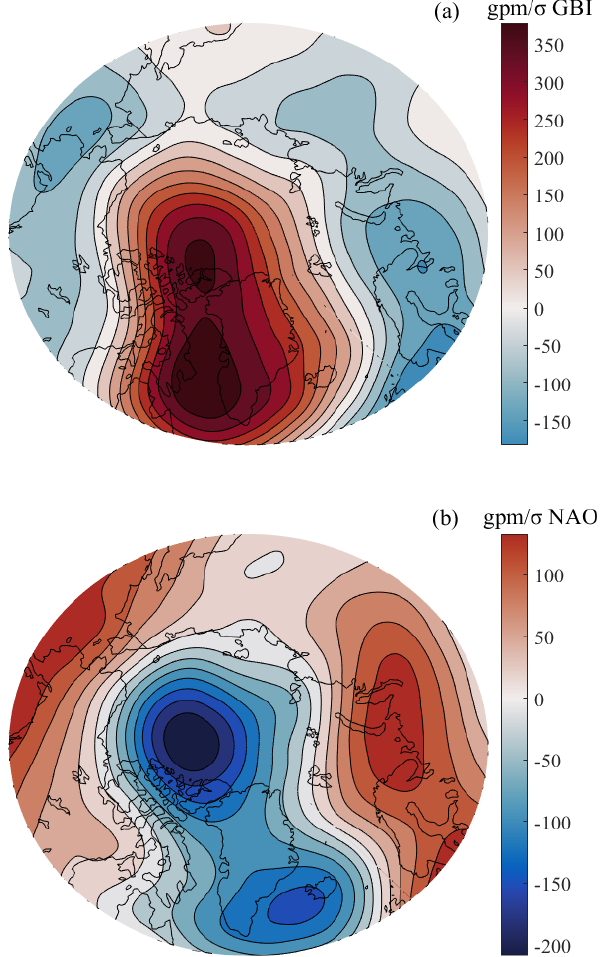
Figure 13. Regression fields slope of 2000–2018 JJA 500hPa geopotential height from ERA5 regressed with GBI (a) and NAO (b) index. Slope maps are scaled to show the 500hPa geopo- tential height change from ERA5 in geopotential meters (in gpm) for a 1 standard deviation change in GBI (a) and NAO (b) circula- tion